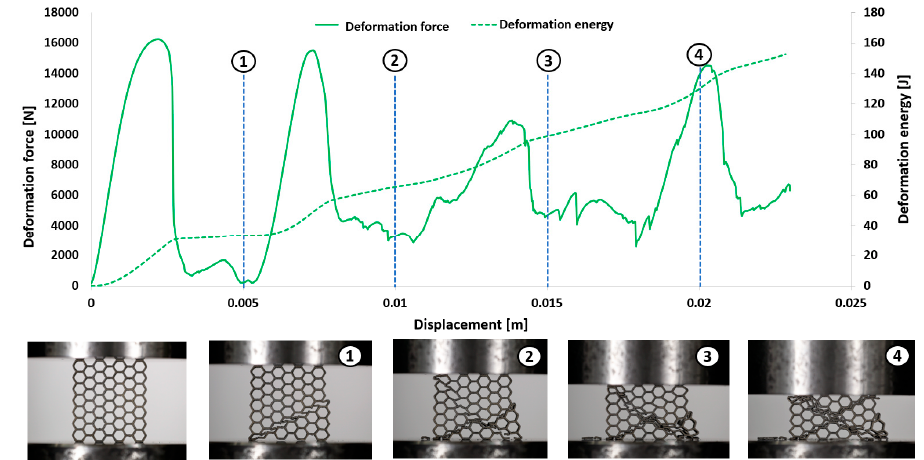
Figure 14. Deformation process of specimen No. 3 manufactured additively with LENS (1 - 4 stages of deformation during static compression test).